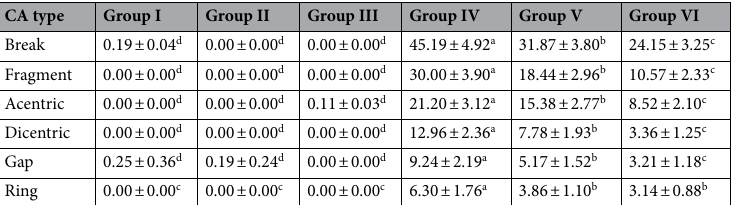
Table 4. The effect of AFM 2 and quercetin applications on CAs frequencies. Group I: control, Group II: 25 mg/kg b.w quercetin, Group III: 50 mg/kg b.w quercetin, Group IV: 16 mg/kg b.w AFM 2 , Group V: 16 mg/ kg b.w AFM 2 + 25 mg/kg b.w quercetin, Group VI: 16 mg/kg b.w AFM 2 + 50 mg/kg b.w quercetin. Values are shown as mean ± SD (n = 6). For the frequency of CAs, 600 cells in each group were analyzed. Means shown with different letters (a–d) on the same line are statistically significant ( p <